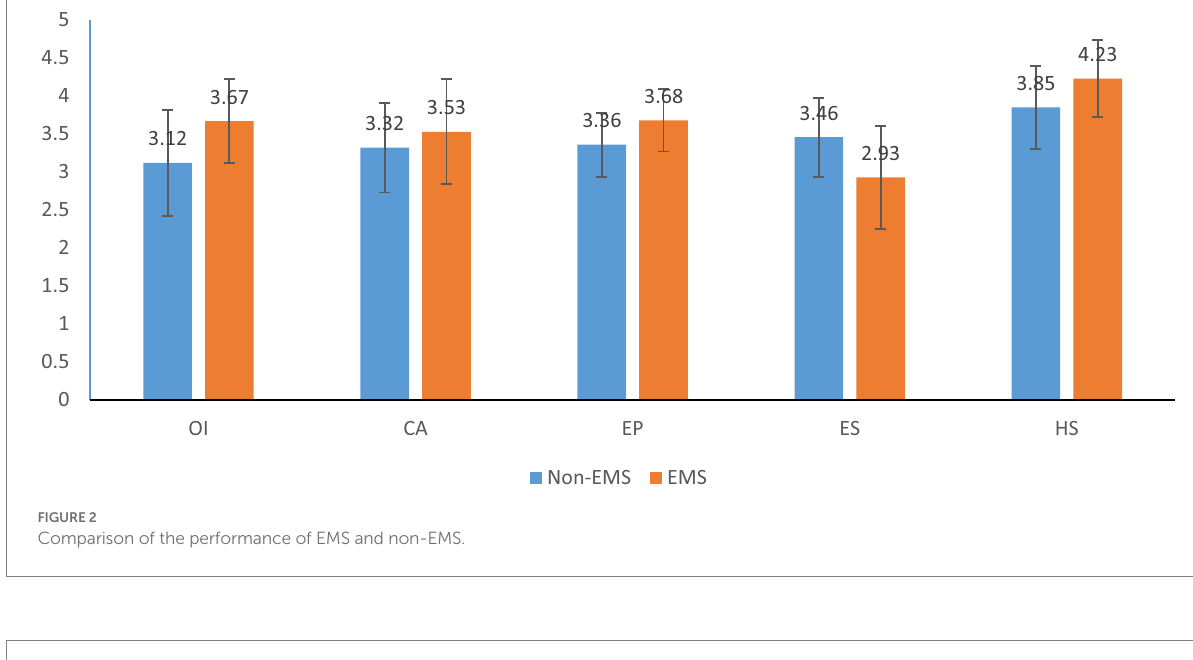
FIGURE 2 Comparison of the performance of EMS and non-EMS.